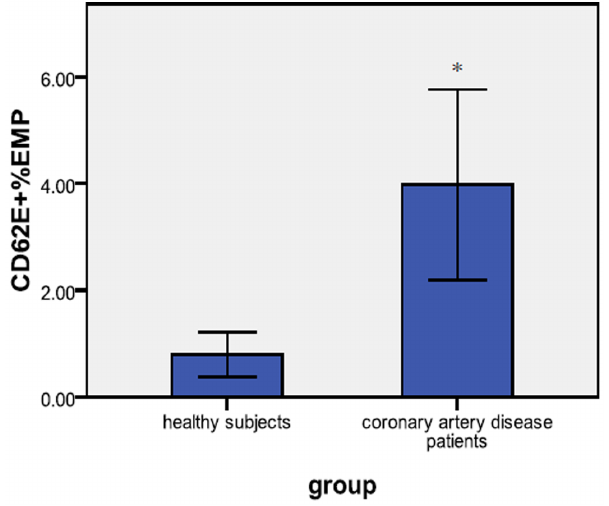
Figure 2. Percentage of CD62E + SEMPs in CAD patients and healthy subjects. The graph shows the mean percentage of CD62E + SEMPs in blood samples obtained from CAD patients and healthy subjects (mean 6 SD). *P ,